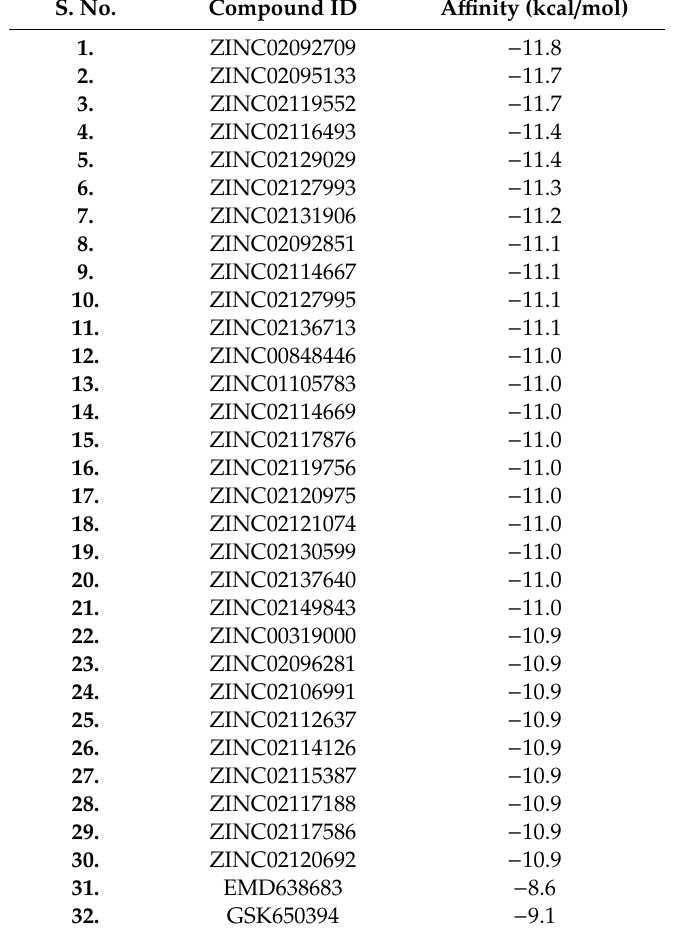
Table 3. List of the top 30 hits selected based on their binding a ffi nity towards SGK1. S.